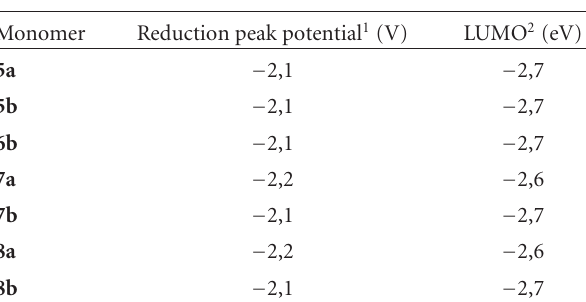
Table 3: LUMO energy levels and reduction potentials of corre- sponding monomers 5a/b–8a/b .